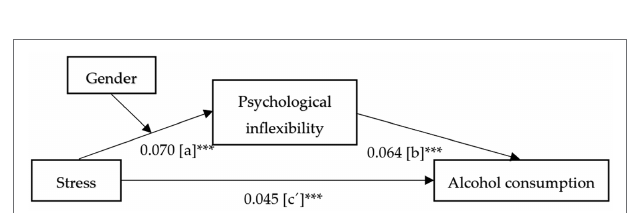
FIGURE 2 | Unstandardized regression coefficients for the mediation effect of psychological inflexibility on the relationship between stress and alcohol consumption, moderated by gender. *** p < 0.001. Moderated mediation index = 0.004 CI